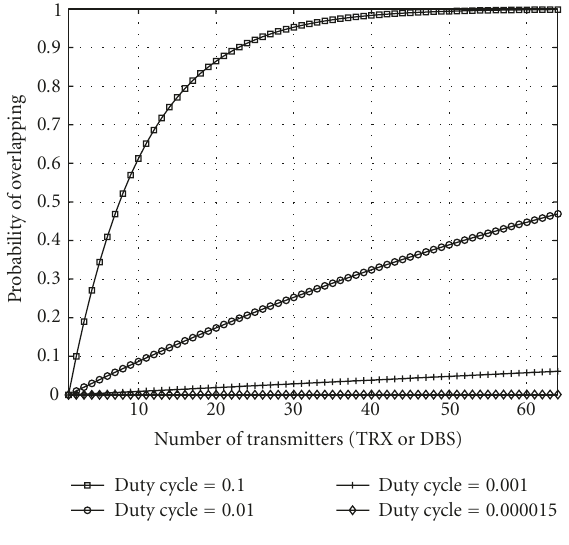
Figure 2: The probability of